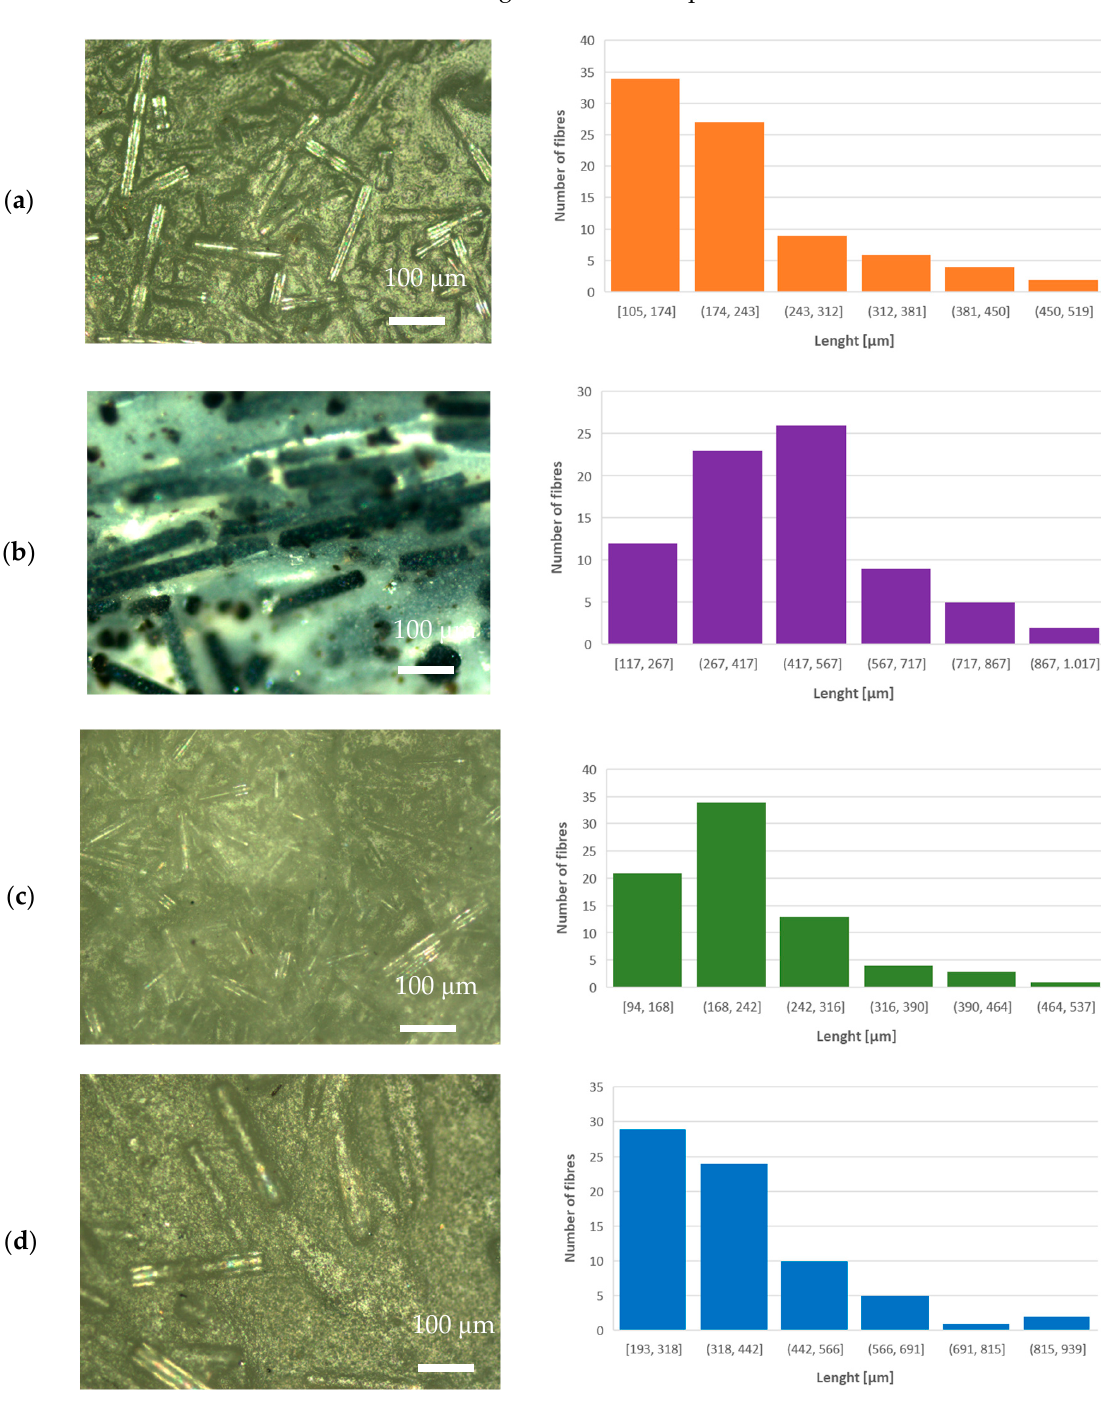
Figure 2. Optical microscope images ( left-hand side ) and length distribution of milled fibers ( right-hand side ) of ( a ) PLA–WG, ( b ) PLA–IPG, ( c ) PLA–HYBG, and ( d ) PLA–ARG composites.